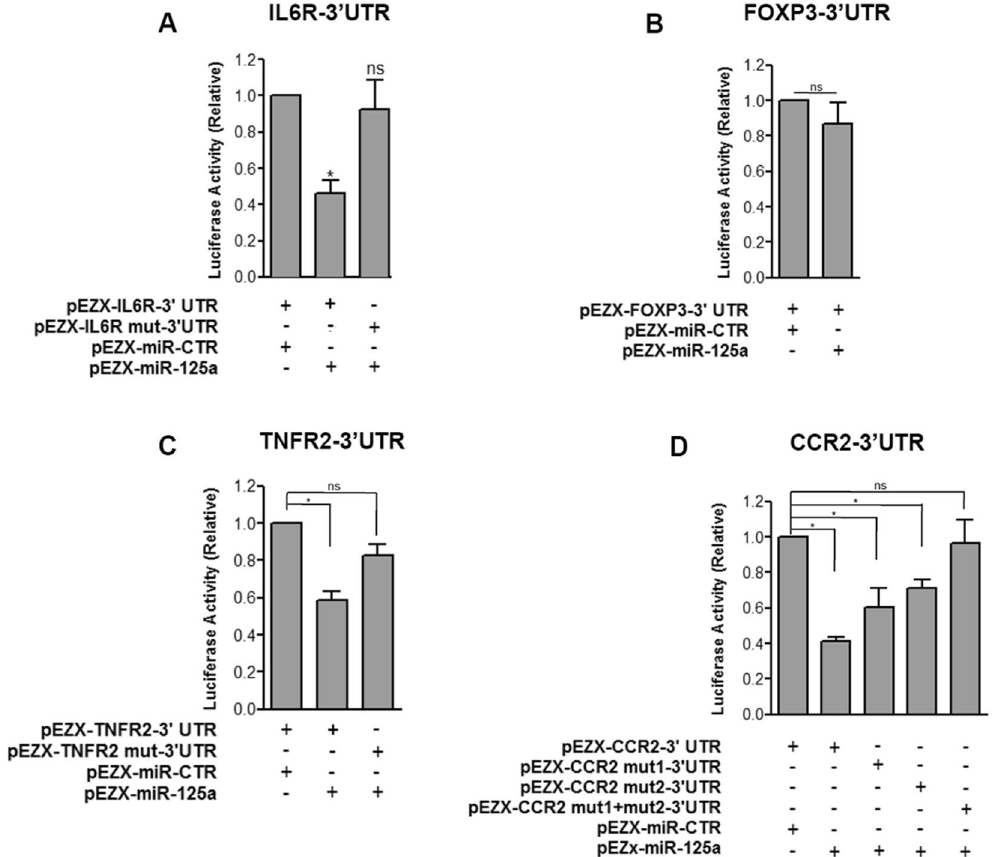
Figure 3. TNFR2 and CCR2 are targets of microRNA miR-125a-5p. Luciferase activity in HeLa cells transfected with ( A ) IL6R (wt, mutated)-, ( B ) FOXP3-, (C) TNFR2 (wt, mutated)- or ( D ) CCR2-3 ′ UTR (wt, mutated)- Firefly Luciferase reporter plasmid together with miR-125a-5p or with scrambled microRNA expressing vector. Firefly luciferase activity was divided by the Renilla luciferase activity to correct eventual differences in transfection efficiency. Bars represent mean + SD of 3 independent experiments. * p < 0.05 paired student’s t test